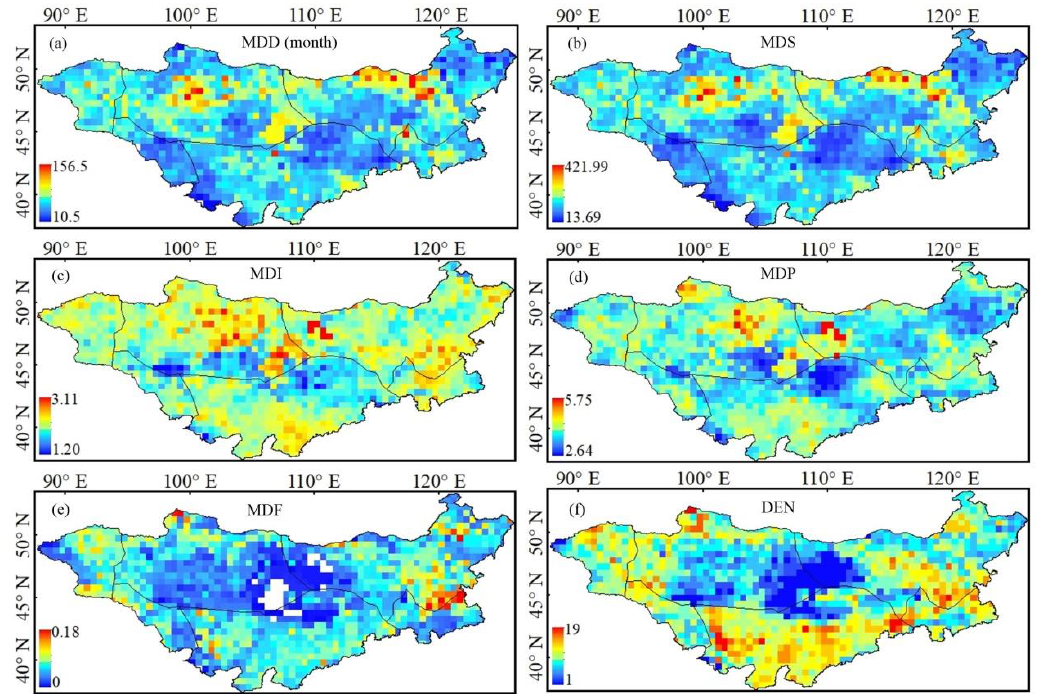
Figure 7. Spatial characteristics of drought events from 1959 to 2018. ( a ) MDD, ( b ) MDS, ( c ) MDI, ( d ) MDP, ( e ) MDF, ( f ) DEN.